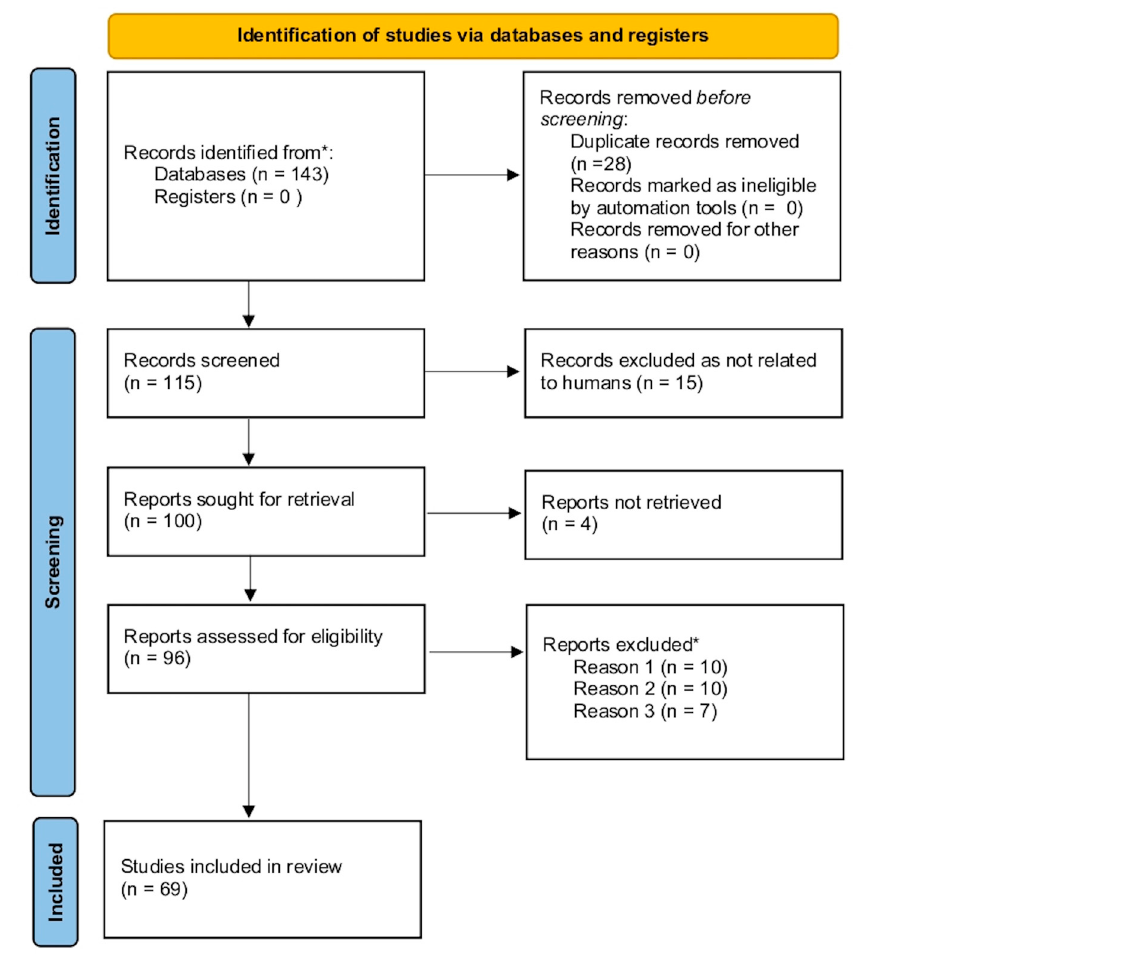
Figure 1. Preferred Reporting Items for Systematic Reviews and Meta-Analysis (PRISMA) on the interaction between MSCs and microenvironment in psoriasis [17].